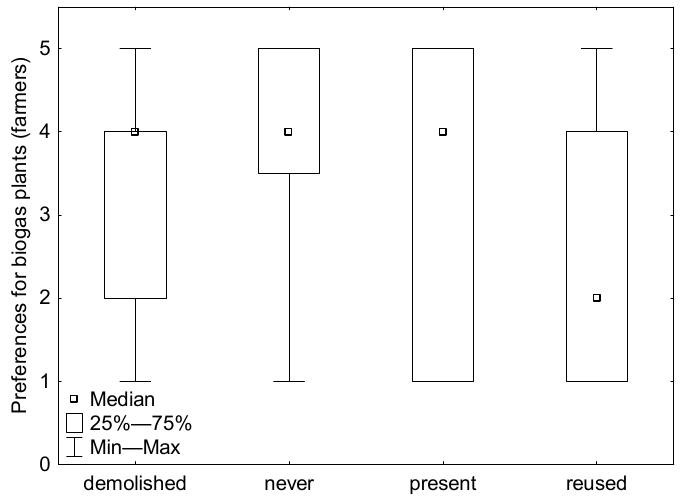
Figure 7. Boxplot of interest in biogas plants according to the owning of an abandoned premise.